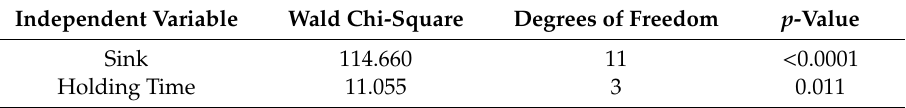
Table 4. Omnibus test for model e ff ects of sample holding time and sampling location. Independent